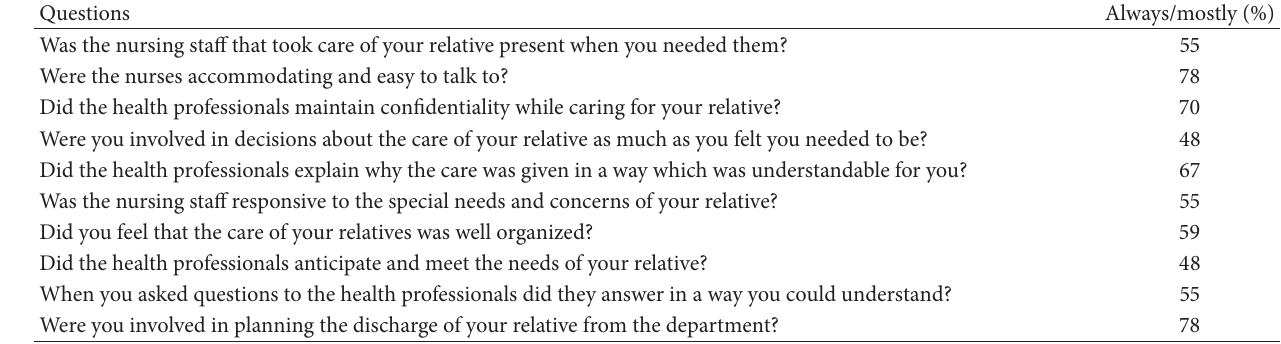
Table 1: The 10 statements from the questionnaire, each with the percentage of respondents indicating that they were always or almost always agreeing to the statement. A percentage lower than 70% is an indication that improvement is needed [14].